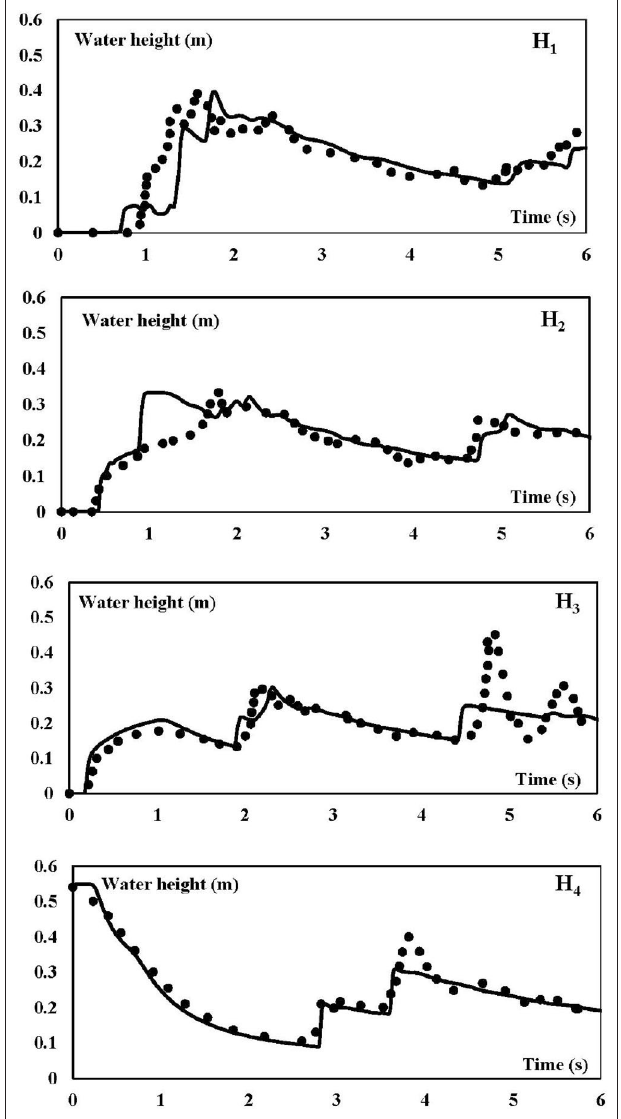
FIGURE 2 | Test case I. Time history of the water height at probes H 1 , H 2 , H 3 , and H 4 . Solid lines: DBE numerical results. Dots: Experimental